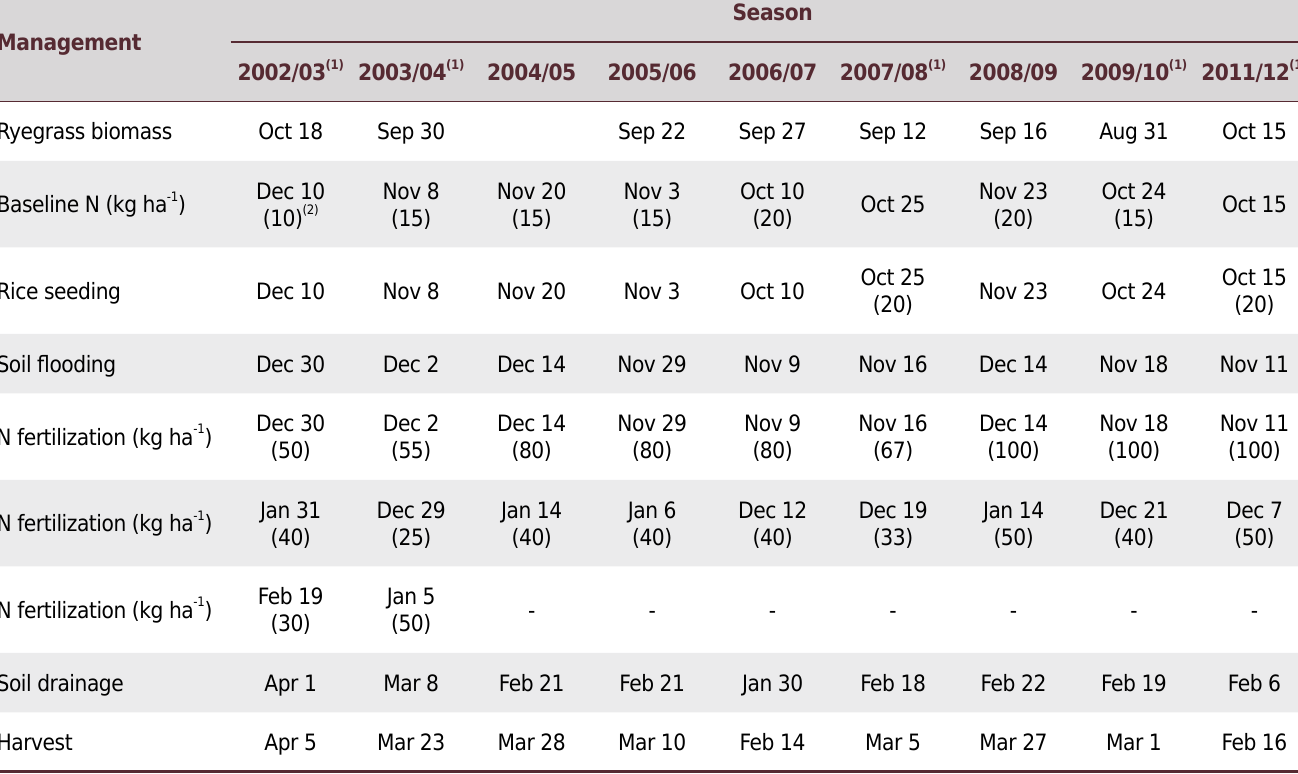
Table 1. Management practices in the rice growing seasons